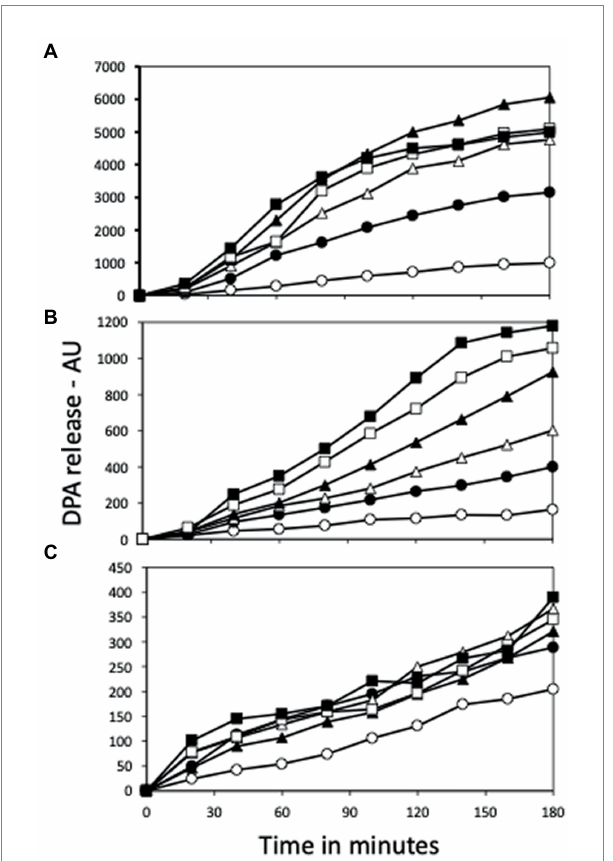
FIGURE 7 AGFK germination of (A) PS832 (wt), (B) PS4487 ( ydfS ) and (C) PS4488 ( yetF ) spores after various heat activation times. Spores of various strains at an OD 600 of 1 were incubated in water at 80 ° C, and at various times aliquots were removed and cooled and then germinated with AGFK and germination followed in a plate reader measuring fluorescence of released DPA in AU as described in Methods. All values shown are averages of duplicate determinations. The symbols for the various heating times are: 0 min – ○ ; 15 min – ● ; 30 min – △ ; 60 min – ▲ ; 90 min – □ ; and 120 min – ■ .